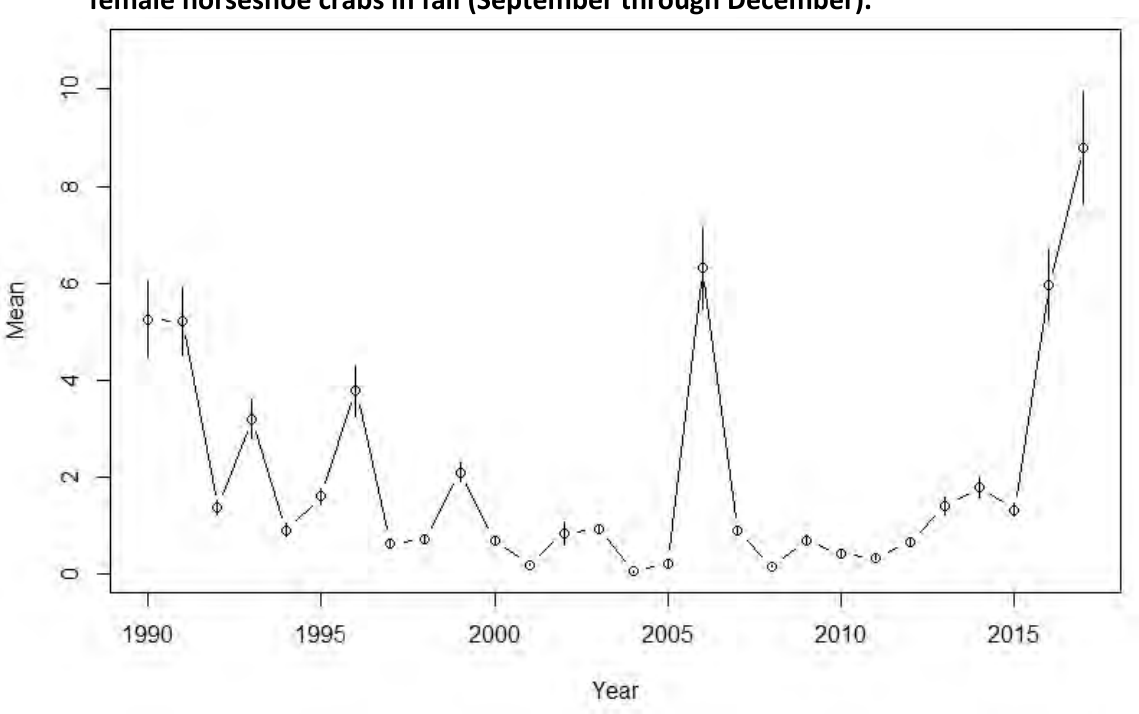
Figure 58. Delaware Fish and Wildlife Adult Trawl Survey abundance index for adult male horseshoe crabs in fall (September through